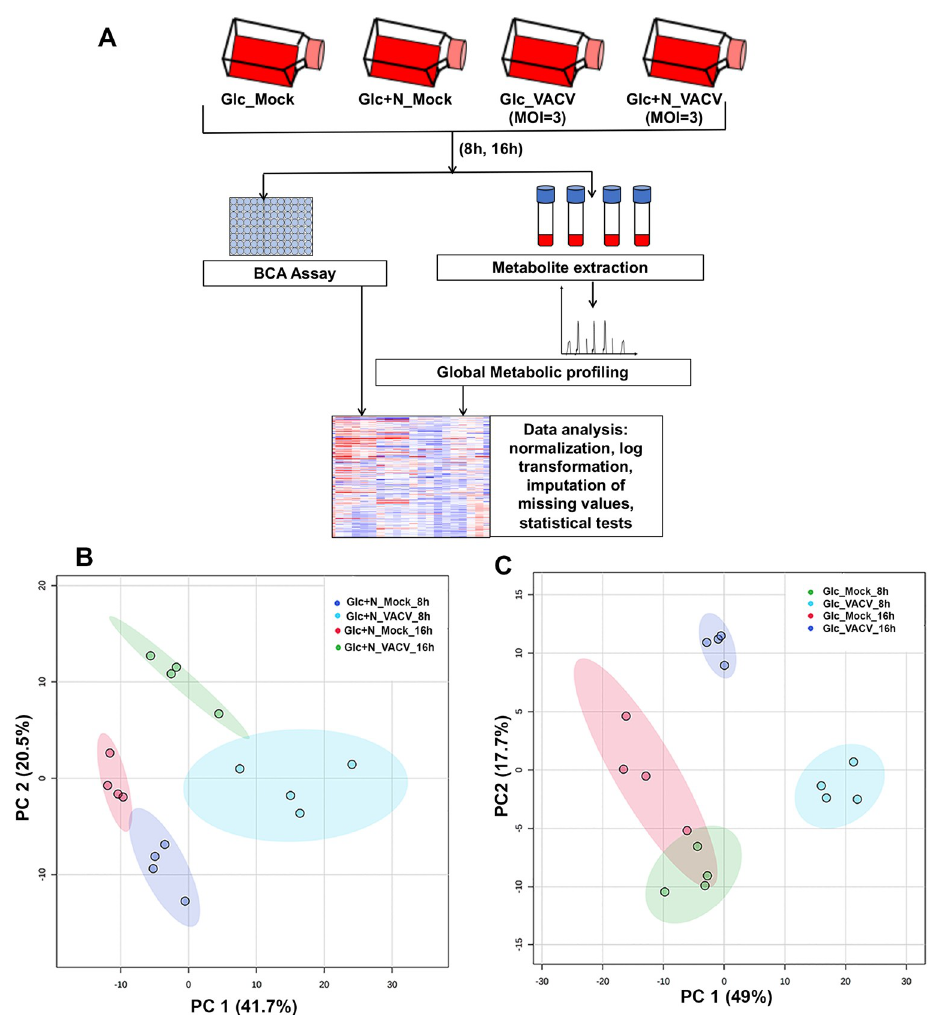
Fig 1. VACV infection reprograms cellular metabolism profoundly and globally under the glutamine-depletion conditions. (A) Experimental design of global metabolic profiling. Four biological replicates of HFFs per treatment were either mock-infected or infected with VACV at an MOI of 3 for either 8 or 16 hours in medium with glucose (Glc) or glucose plus asparagine (Glc+N). Metabolites were extracted, and their levels were measured. (B & C) Principal component analysis (PCA) showing a clear separation between VACV-infected and uninfected HFFs in glucose plus asparagine medium (B) and in HFFs in glucose only medium (C). Each small circle indicates one sample. The shaded region indicates the 95% confidence interval. PC1 represents the effect of VACV infection and PC2 represents the effect of